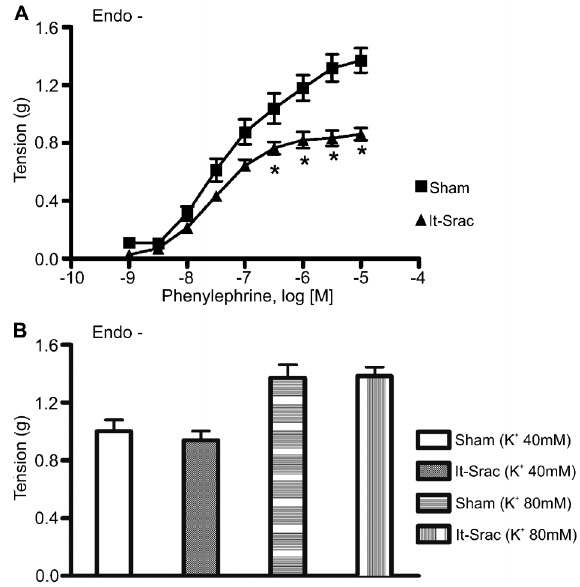
Figure 3. Contractile responses to phenylephrine and high K + in pressure-overloaded rat thoracic aortas. Contractile responses to phenylephrine ( A ) and high K + ( B ) were constructed in endothe- lium-denuded (Endo-) aortic rings obtained from rats 8 weeks after suprarenal abdominal aortic coarctation (lt-Srac) or sham surgery (Sham). Data are reported as means±SE in grams of developed force (n=13-16). A , *P , 0.05, lt-Srac vs Sham (two-way ANOVA with the Bonferroni post hoc test). B , P not significant, Sham (K + 40 mM) vs lt-Srac (K + 40 mM), and Sham (K + 80 mM) vs lt-Srac (K + 80 mM) (unpaired Student t -test).